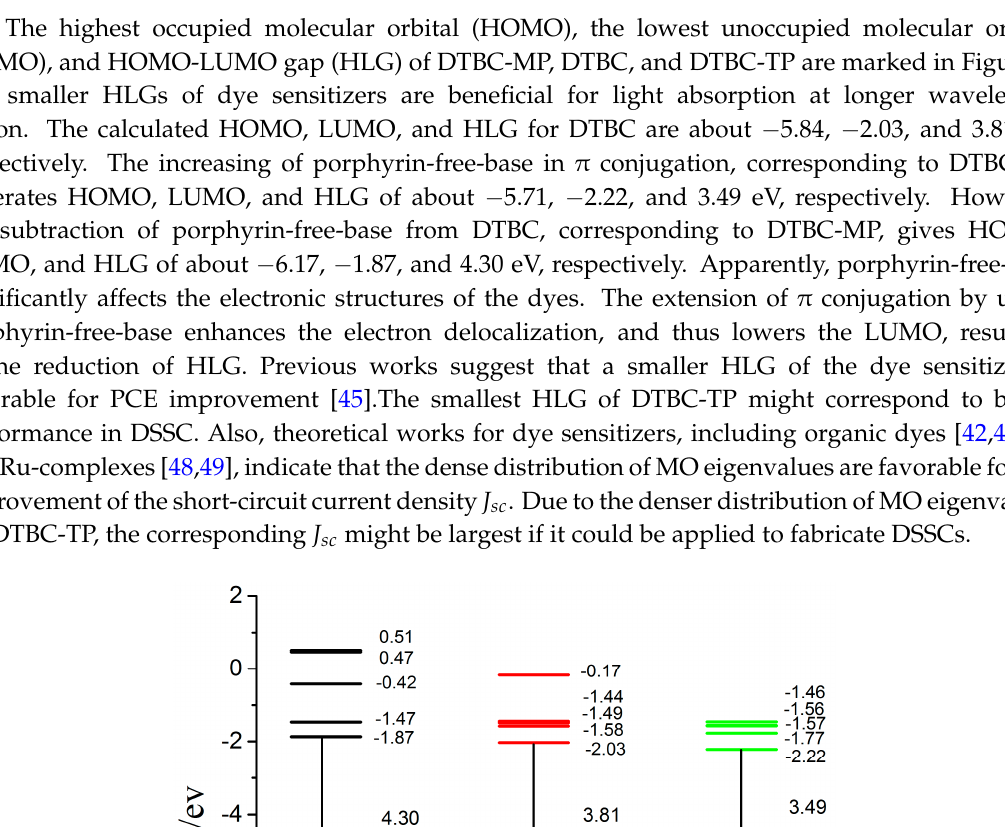
Figure 4. The simulated absorption spectra for DTBC-MP, DTBC and DTBC-TP based on time dependent density functional theory (TDDFT) calculated results with CAM-B3LYP/6-31G(d,p). The 0.333 eV of half-width at half-maximum was applied for absorption spectra